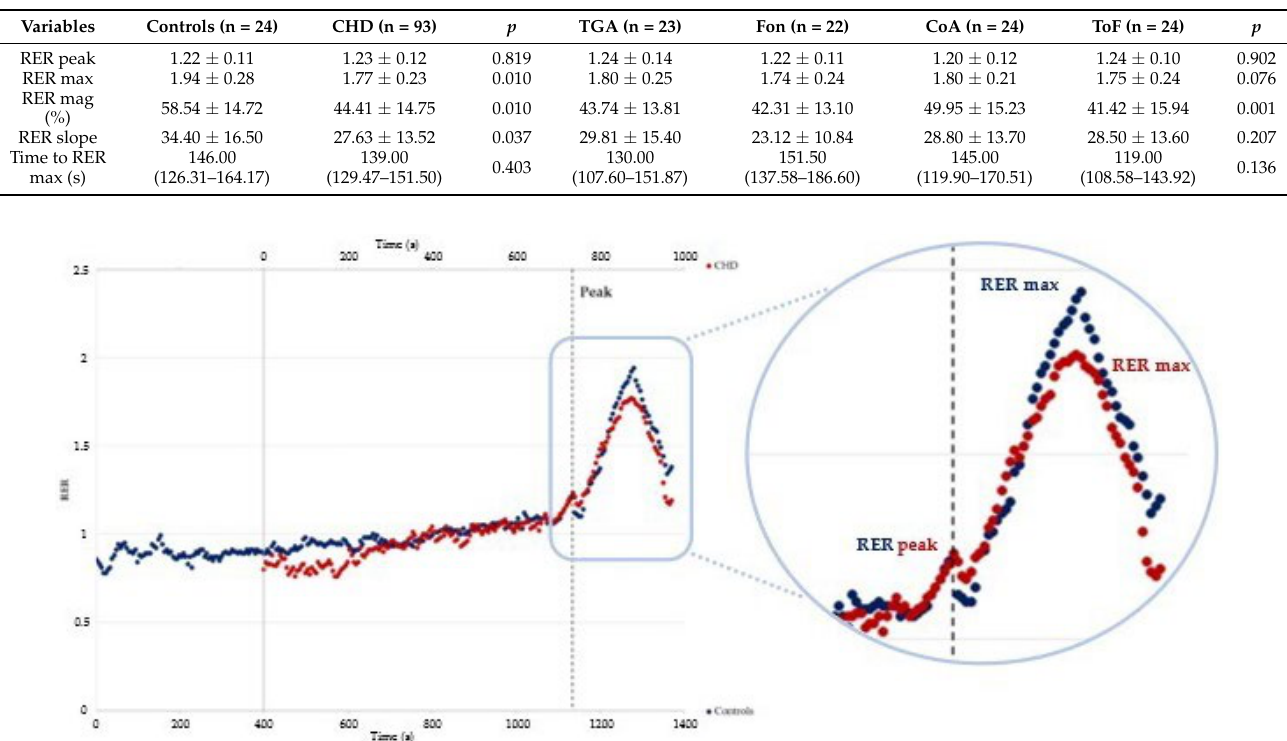
Figure 2. Example of two patients (a healthy subject in blue and a patient with CHD in red) presenting the same respiratory exchange ratio at peak exercise (RER peak) but different maximal values of respiratory exchange ratio during the recovery phase (RER max).